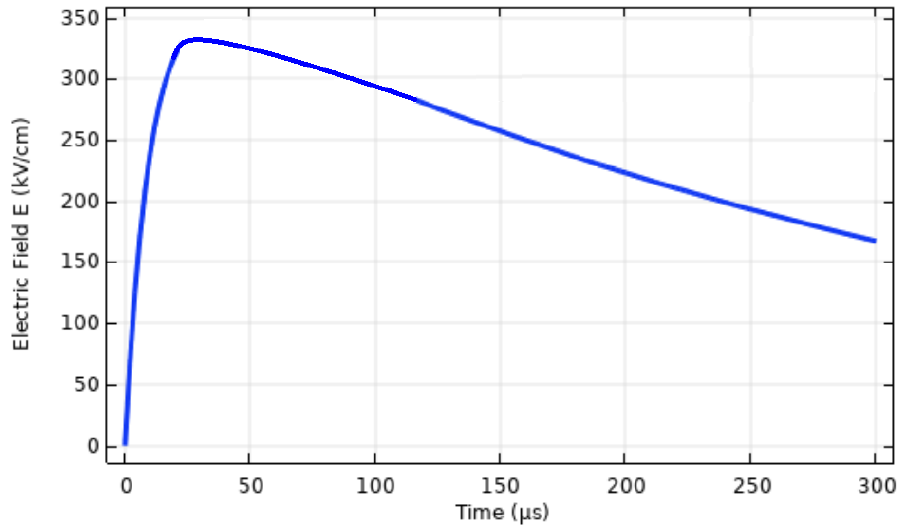
Figure 10. Electrical field on standard and add-on III LPS copper strip.